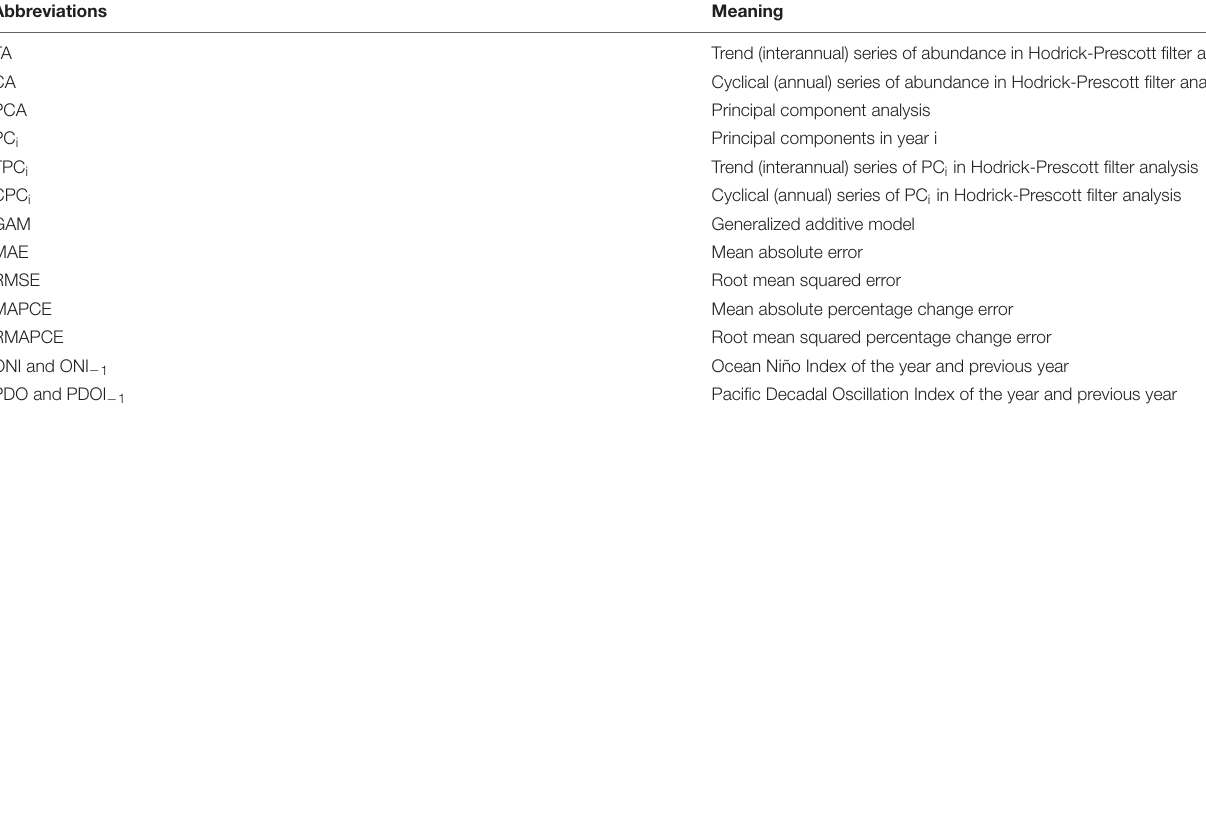
TABLE A1 | Important abbreviations and their